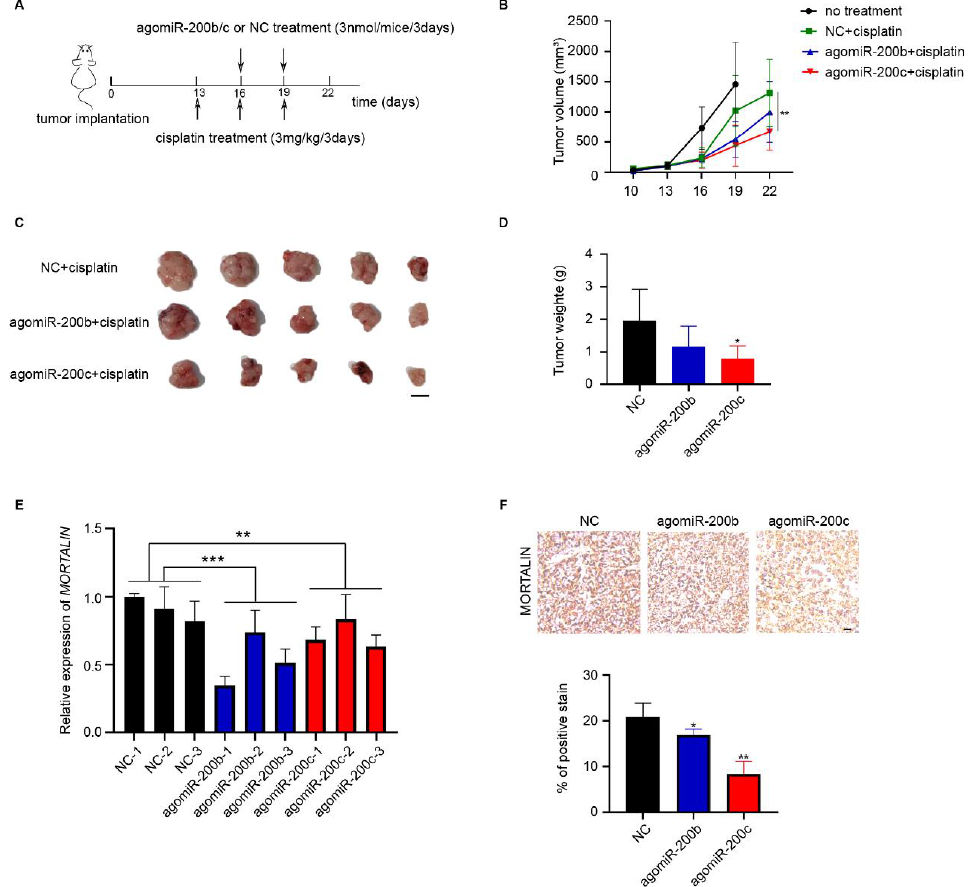
Figure 4. miR-200c suppresses chemoresistance of ovarian cancer cells in vivo. ( A ) Schematic diagram of the experimental design of a subcutaneous tumorigenesis model in nude mice. ( B ) After subcutaneous tumor inoculation for 10 d, the subcutaneous tumor volume was measured every three days to plot the tumor growth curve. ( C ) Images of isolated tumors on day 22 (scale bar, 1 cm). ( D ) Weights of the isolated tumors. ( E ) mRNA expression levels of mortalin in ovarian cancer tissues treated with agomiR-200b/c or NC were determined by qPCR. ( F ) The expression of mortalin in isolated tumor tissues were determined using immunohistochemistry (scale bar, 10 μm). Biological replicates (n = 5). * p < 0.05, ** p < 0.01, *** p < 0.001.